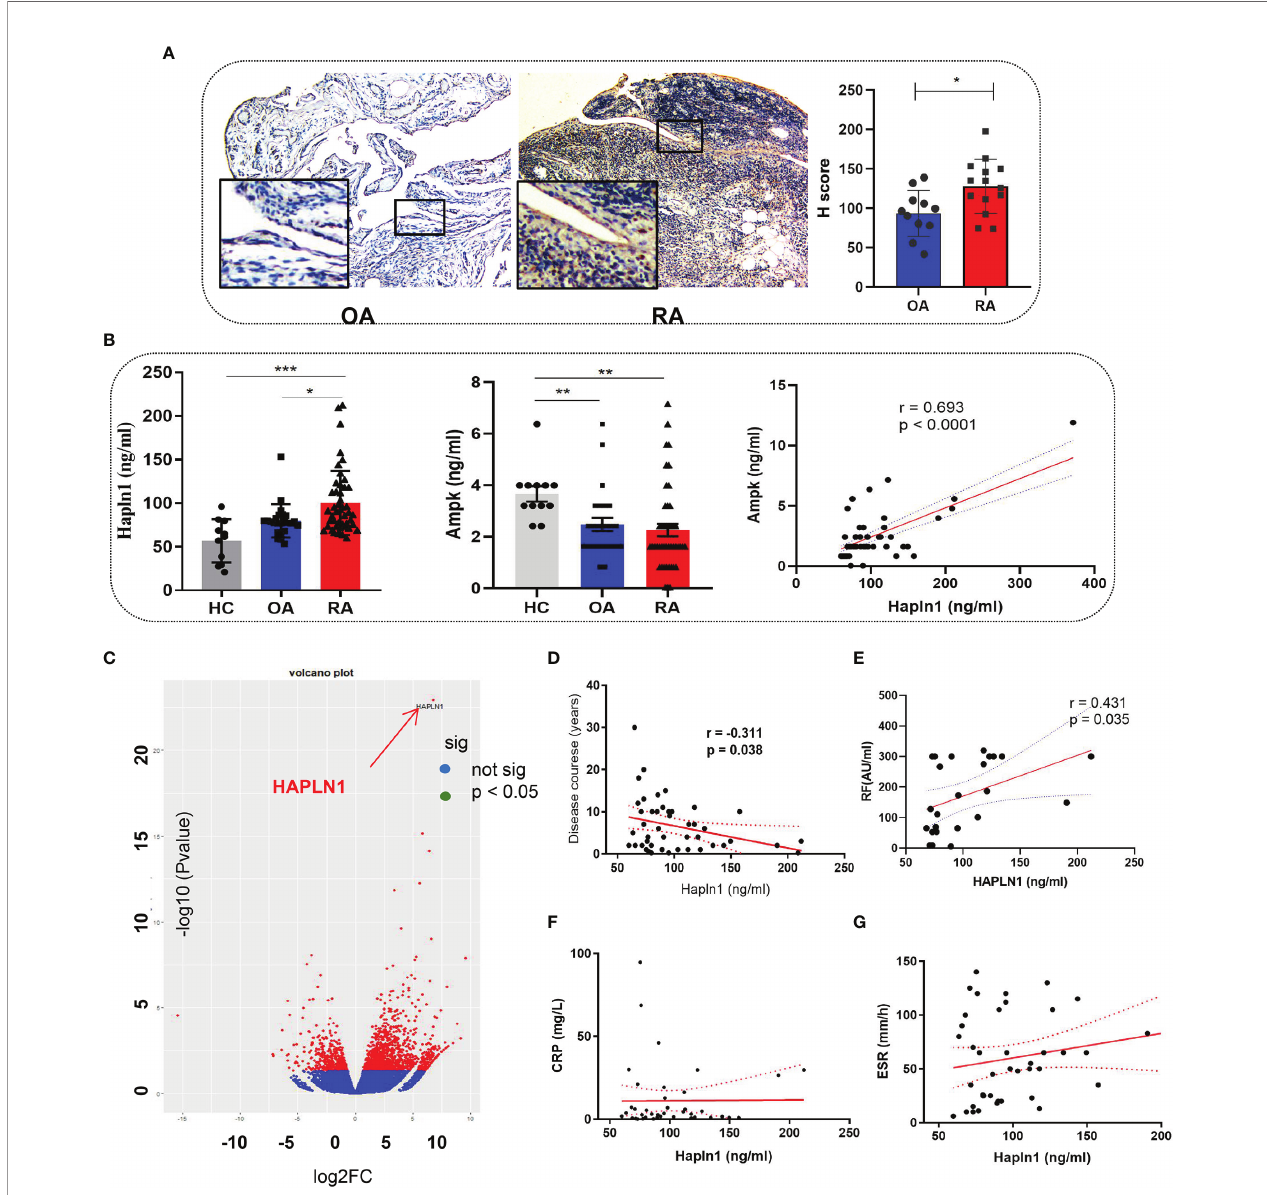
FIGURE 1 | HAPLN1 is up-regulated in RA patients and positively correlated with AMPK. (A) Increased HAPLN1 expression, quanti fi ed by the H score, in RA (n=20) than OA (n=17) synovium (magni fi cation of gross looking, 10×5; magni fi cation of foci in the framed, 10×20). (B) Plasma HAPLN1 levels examined by ELISA were signi fi cantly enhanced in RA (n=61) patients than OA (n=20) patients and HC (n=12), while AMPK levels were decreased in both OA and RA patients compared to HC. Plasma HAPLN1 and AMPK levels were signi fi cantly positively correlated (r = 0.693, p < 0.0001). (C) Volcano plot showing higher expression of the HAPLN1 gene in FLSs from RA than OA patients (n=3 in each group). (D, E) Plasma HAPLN1 levels negatively correlated with the disease course (r = -0.311, p = 0.038) and showed a moderately positive correlation with RF levels (r = 0.431, p = 0.038) of RA patients. (F, G) No signi fi cant correlation between the HAPLN1 level and ESR and CRP. *p < 0.05; **P < 0.01; ** *p <